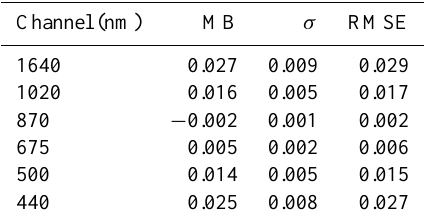
Table 2. Main statistics of the AOD differences obtained by means the Sun-Moon gain factor method and the Lunar Langley method for one head at Izaña for May and June, 2014. We have included mean bias (MB), standard deviation ( σ ) and root mean square error (RMSE)